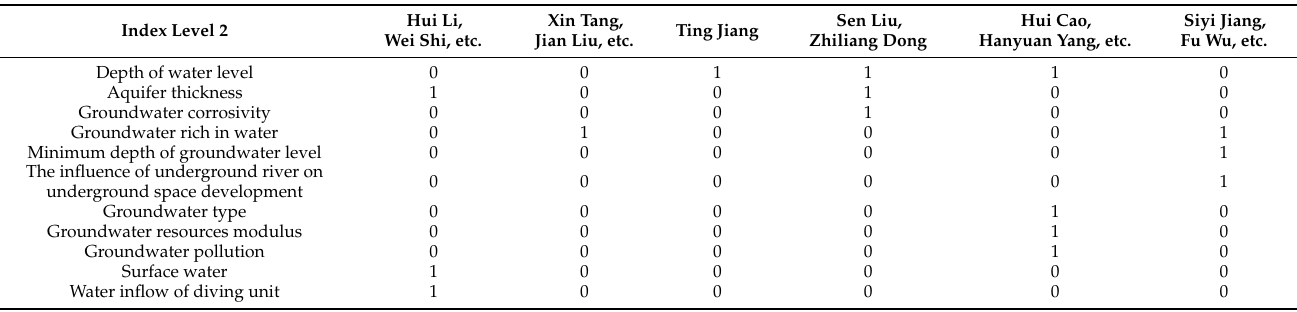
Table A11. Second level index binarization